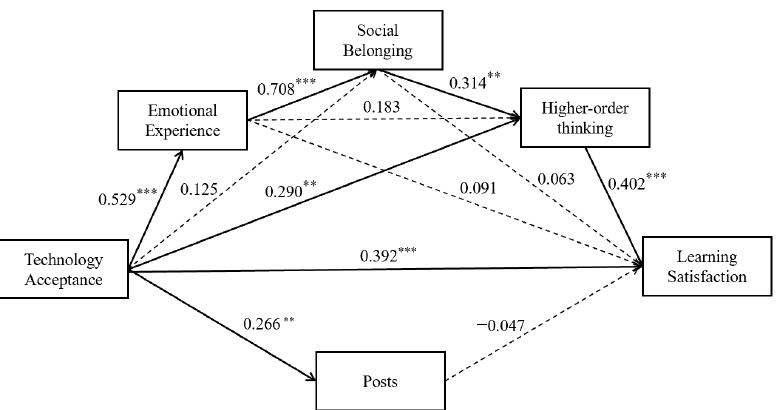
Figure 2. Research model predicting blended learning satisfaction: path coefficients. Note: standardized coefficients are displayed above. Solid arrows: path coefficient is significant, dashed arrows: path coefficient is insignificant. ** p < 0.01, *** p < 0.001.